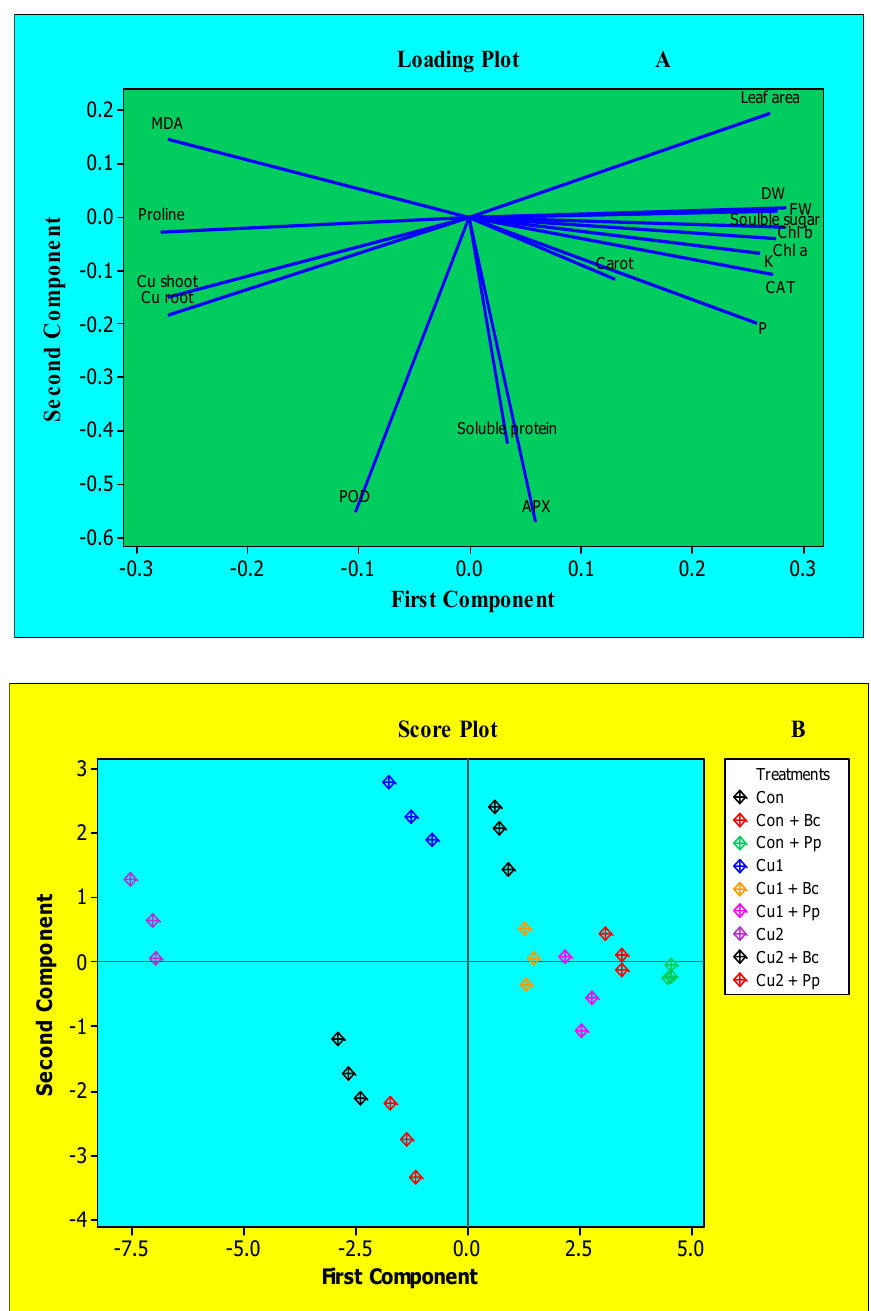
Figure 3. Principal component analysis (PCA) to understand parameter and treatment variability in maize plants. ( A ) The parameters included FW (fresh weight) DW (dry weight), leaf area, Chl a (chlorophyll a ), Chl b (chlorophyll b ), Carot (carotenoids), soluble sugars, soluble protein, proline, MDA (malondialdehyde), CAT (catalase), APX (ascorbate peroxidase), POD (peroxidase), P (phosphorous) and K (potassium). ( B ) The treatment triangles in di ff erent colors include Control, plants without copper stress and bacterial strains inoculation; Cu 1: plants exposed to 100 µ M CuSO 4 ; Cu 2: plants exposed to 500 µ M CuSO 4 ; P. polymyxa ( Pp ) inoculated plants without CuSO 4 ; Cu 1 + Pp : plants exposed to 100 µ M CuSO 4 and inoculated with P. polymyxa ; Cu 2 + Pp : plants exposed to 500 µ M CuSO 4 and inoculated with P. polymyxa ; B. circulans ( Bc ) inoculated plants without CuSO 4 ; Cu 1 + Bc : plants exposed to 100 µ M CuSO 4 and inoculated with B. circulans and Cu 2 + Bc : plants exposed to 500 µ M CuSO 4 and inoculated with B. circulans .